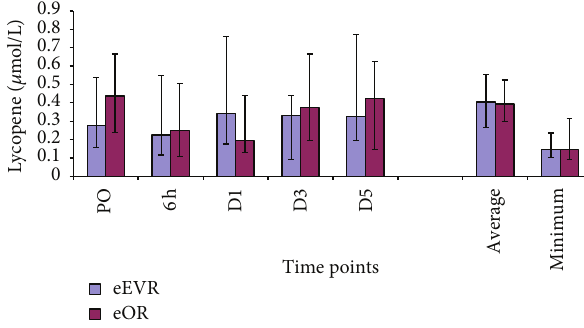
Figure7:SerumvitaminE/lipidratio( 𝜇 mol/L–mmoL/L)expressed as median and IQR.